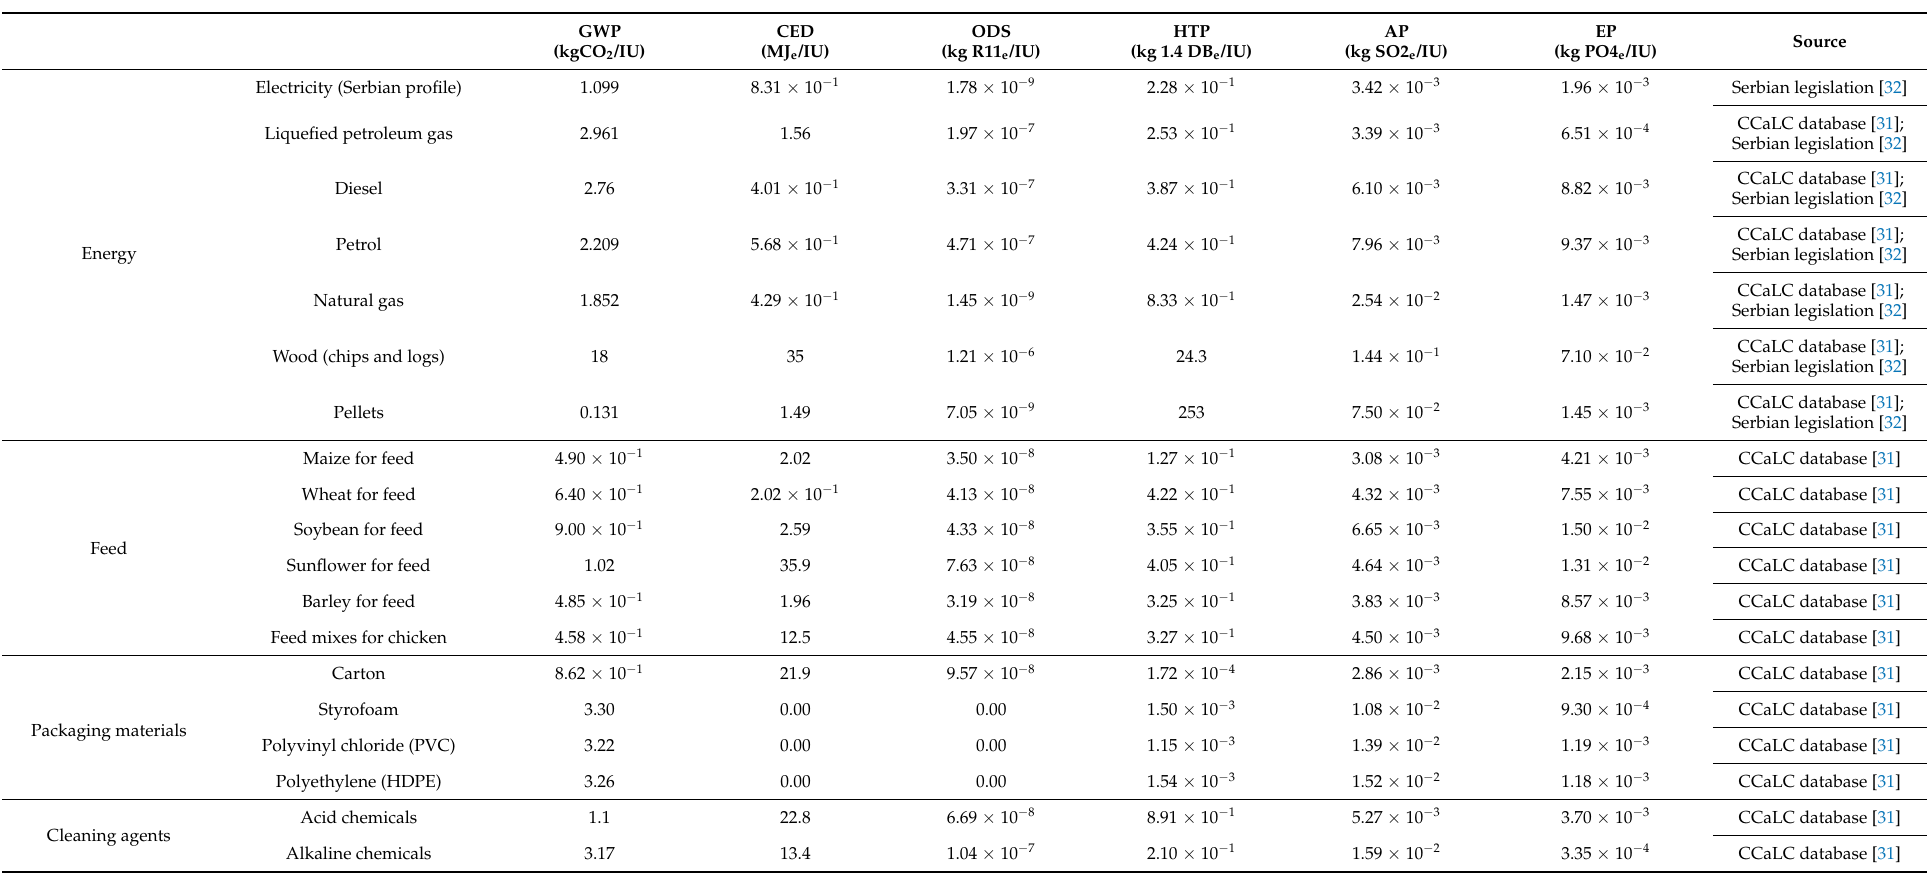
Table 2. Summary of inventory data sources considered in this